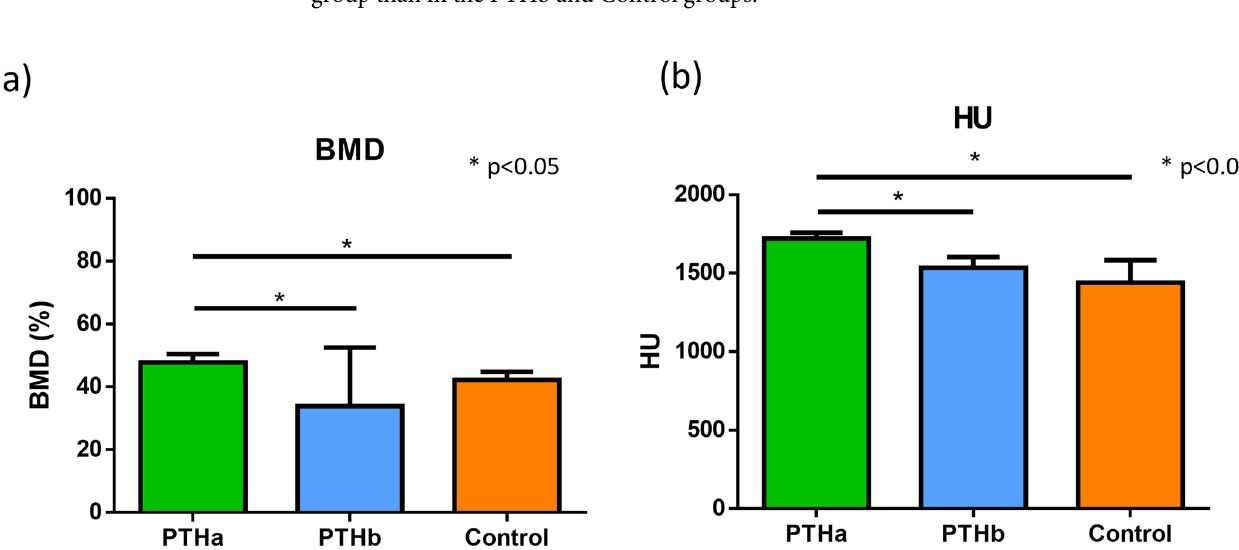
Fig 8. Micro-CT analysis. (a) The BMD value of the PTHa group was significantly higher than those of the PTHb and Control groups. There was no significant difference between the PTHb and Control groups. (b) The HU value of cancellous bone of the PTHa group was significantly higher than those of the PTHb and Control groups. There was no significant difference between the PTHb and Control